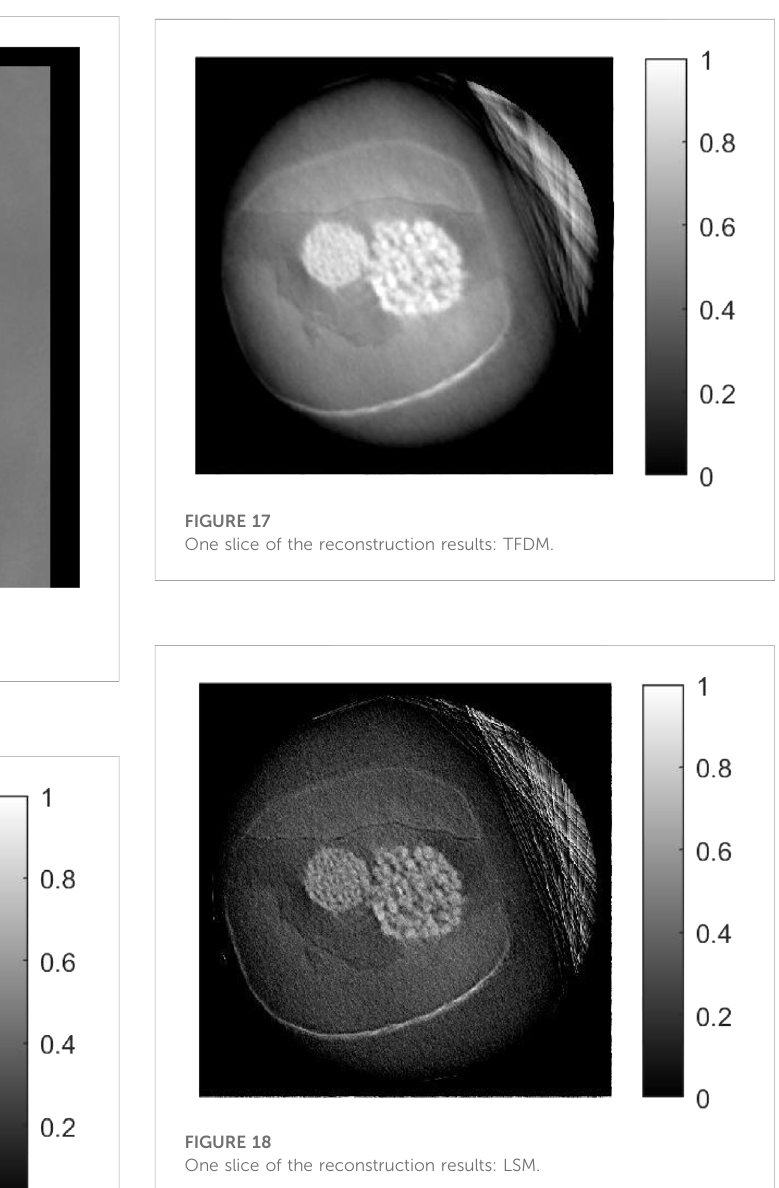
FIGURE 18 One slice of the reconstruction results: